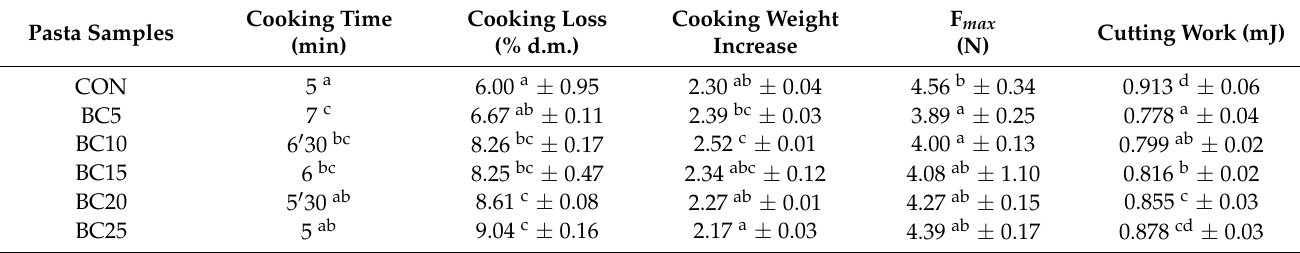
Table 5. Cooking quality and texture of pasta